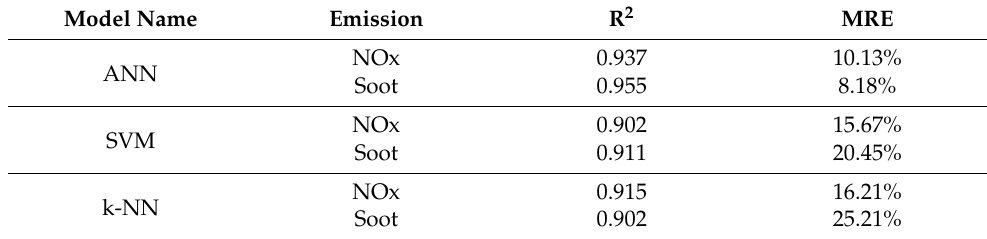
Table 5. Comparison of fitting accuracy of different models.